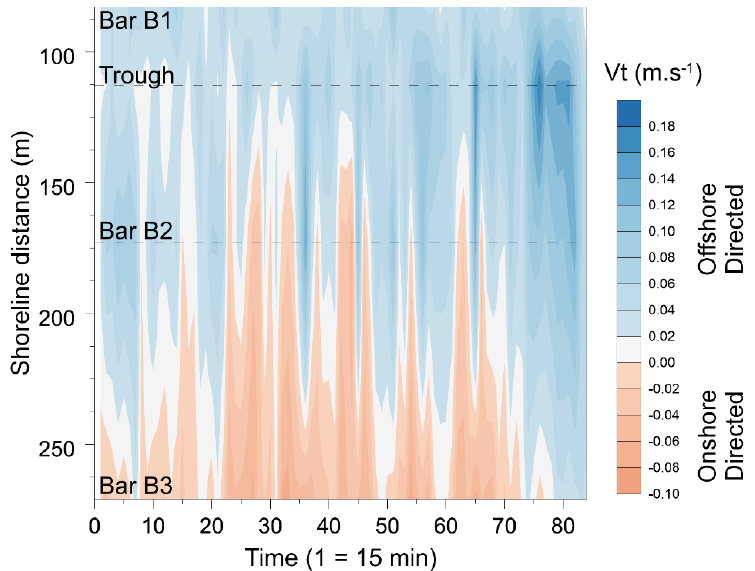
Figure 14. Stacked burst records of mean cross-shore current velocities at high tide showing variations in current direction and velocity across the intertidal zone. Near-bottom currents were measured on each intertidal bar and in the trough on the upper beach (locations are indicated by dashed lines). The horizontal axis does not correspond to a continuous time-series, but to the numbers of successive 15 min burst records obtained at high tide from 2 to 8 June 2013.